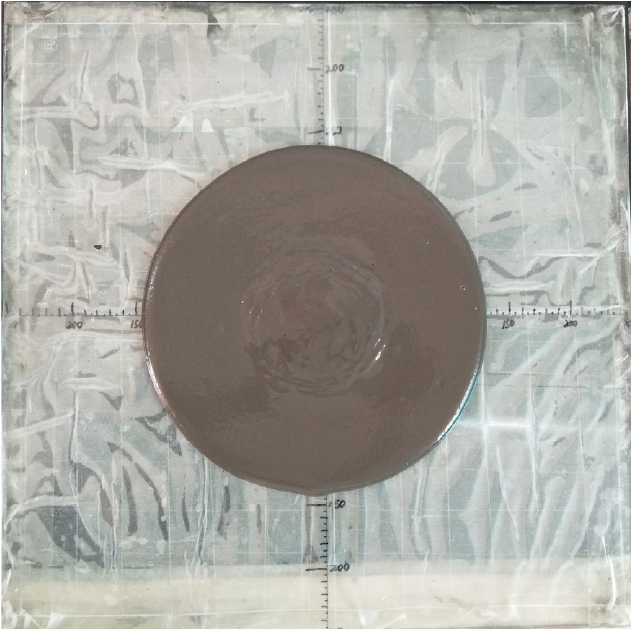
Figure 3. FCPB slurry in the spread test.